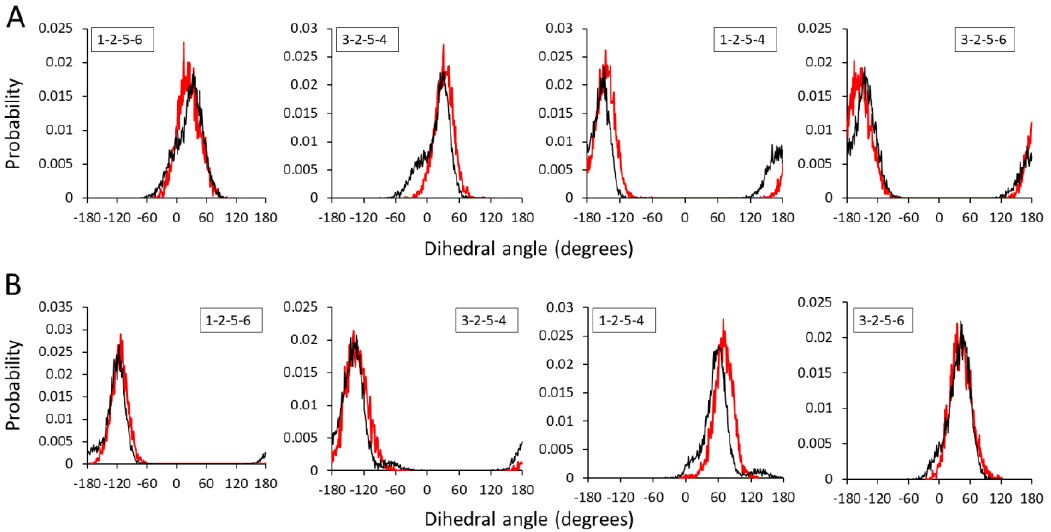
Figure 4. Dihedral angle distributions of AA and CG representations for ( A ) HA1-3 and ( B ) HA1-4. Black and red lines indicate AA and CG representations, respectively.